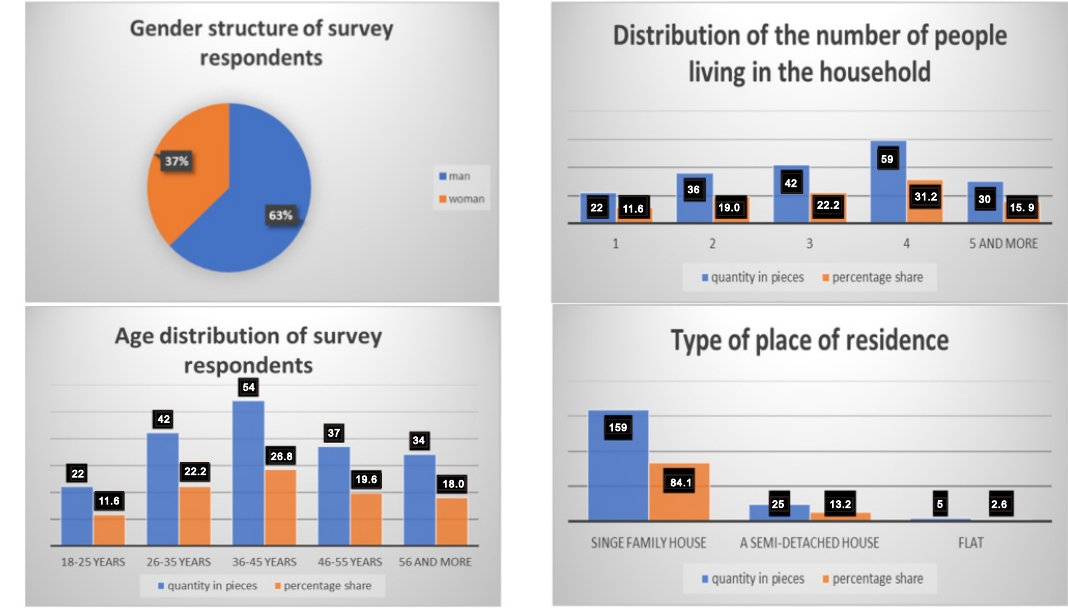
Figure 4. Research sample characteristics.